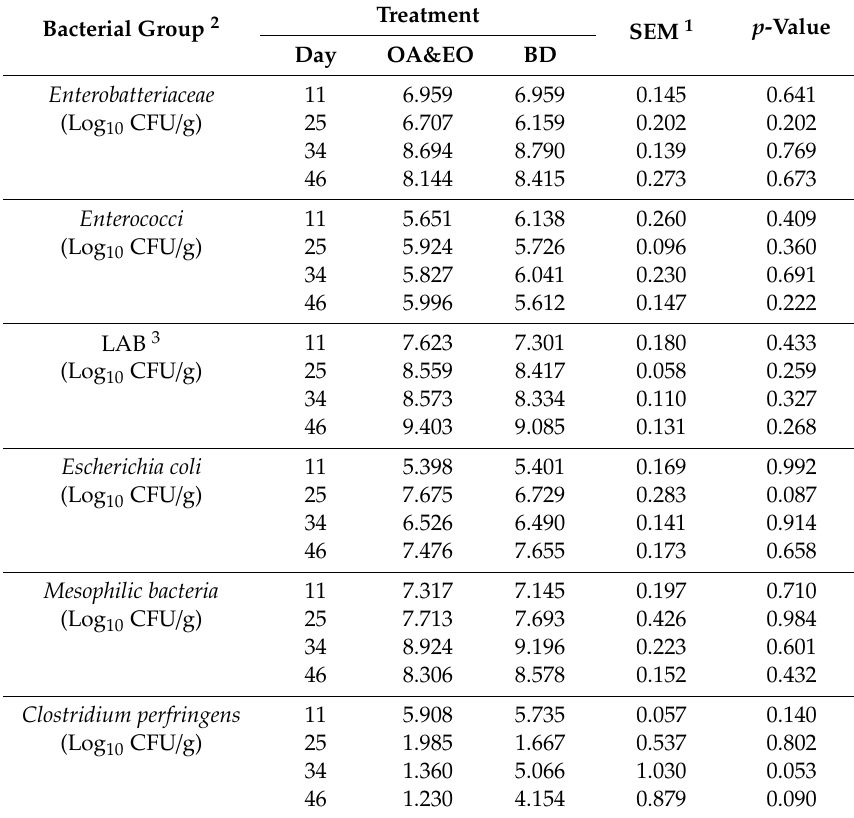
Table 5. Bacterial count of the ileal tract as a ff ected by dietary treatment and sampling time (n = 9 for each treatment within sampling